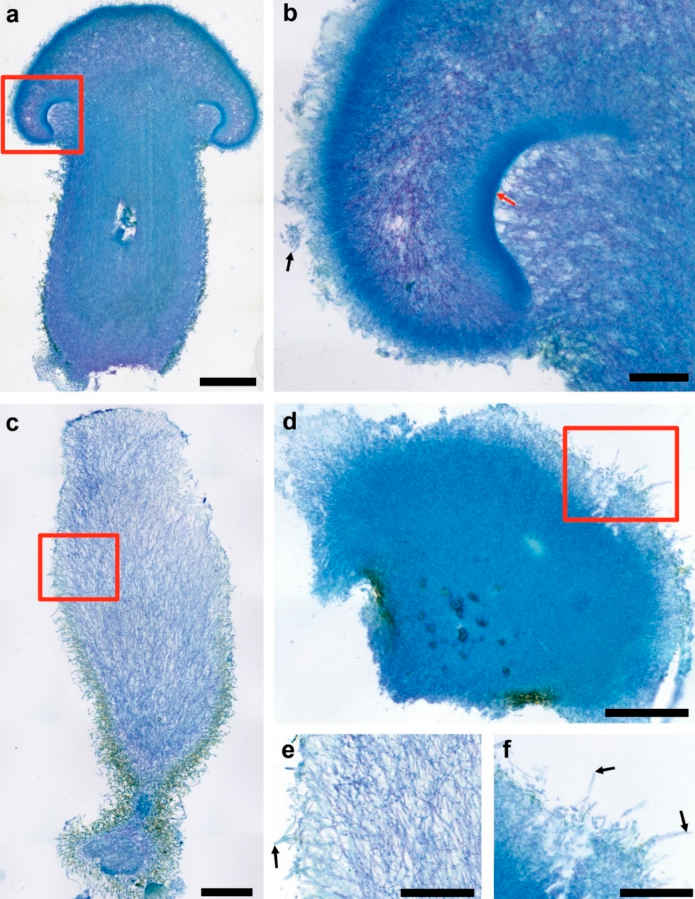
Figure 3. Anatomy of fully grown monokaryotic fruiting structures by C. parasitica . Cultures of C. parasitica ICMP 11668-3, -4, and -9 were grown at 25 ◦ C in the dark for 16–19 days. Fruiting induction (f.i.) took place with fully colonized plates at 20 ◦ C in a 12 h daylight/12 h dark setup at saturated humidity in microfilter-aerated wet chambers. Fully developed fruiting structures were harvested 21 days ( C. parasitica ICMP 11668-3), 27 days ( C. parasitica ICMP 11668-9), and 57 days ( C. parasitica ICMP 11668-4) after f.i. Photographs were taken from toluidine blue O-stained microtome sections of fully developed fruiting structures. ( a ) Fully grown basidiome of C. parasitica ICMP 11668-3 (fruiter type). The tissue rupture in the center of the stipe was caused during the sample processing. The red frame represents the area that is shown in ( b ) on a larger scale. The scale bar represents 0.5 mm. ( b ) Image detail from ( a ) showing the gill cavity that is filled out by the partial veil but also displays a flat intensely stained hymenium (indicated by a red arrow). The black arrow points to hyphal elements of the prominent universal veil on the cap surface. The scale bar represents 100 µ m. ( c ) Fully grown elongated fruiting structure formed by C. parasitica 11668-9 (elongated type) that exhibits an apportionment into a basal stand-like intensely stained condensed structure with a sheath-like pigmented layer lining its outer surfaces and a less dense less intensely stained upper part. The red frame represents the area that is shown in ( e ) on a larger scale. ( d ) Fully grown bloated fruiting structure formed by C. parasitica 11668-4 (stroma type) that shows a faint differentiation into a dense intensely blue strained internal tissue and a less dense outer tissue. The red frame represents the area that is shown in ( f ) on a larger scale. The scale bar represents 200 µ m. The scale bar represents 200 µ m. ( e ) Image detail from ( c ) showing the outer surface of an elongated structure by C. parasitica 11668-9 (elongated type) that contains partially inflated hyphal elements (black arrow). The scale bar represents 100 µ m. ( f ) Image detail from ( d ) showing the outer surface of a bloated structure formed by C. parasitica 11668-4 (stroma type) that consists of partially inflated rather lilac-stained hyphal elements (black arrows). The scale bar represents 100 µ